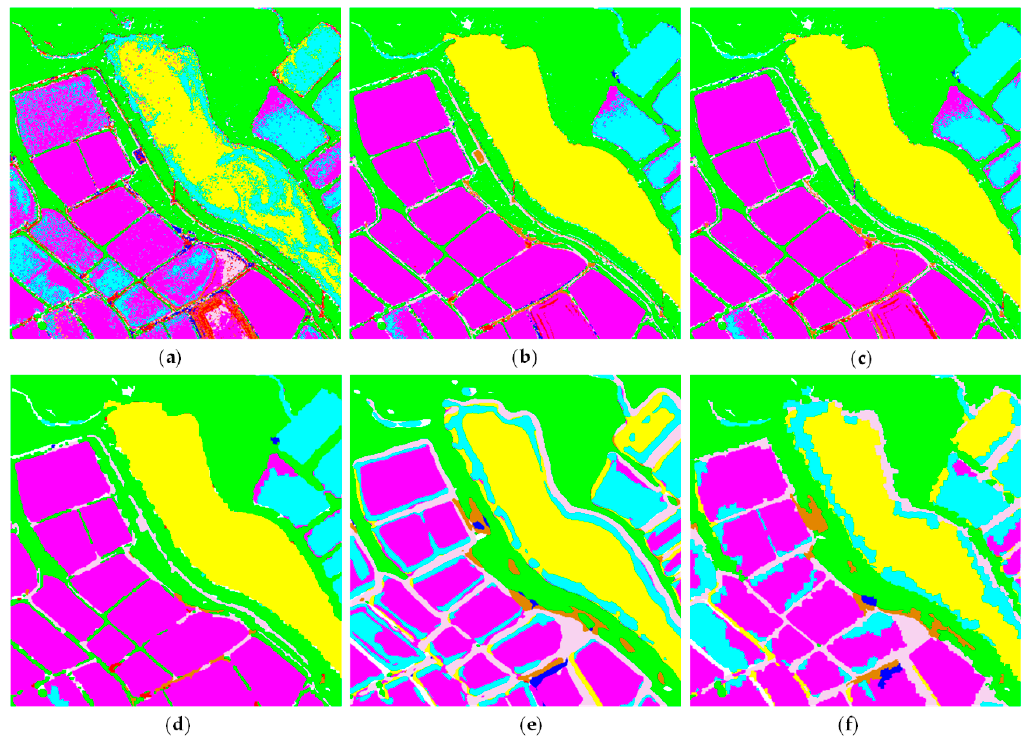
Figure 11. Local details of the classification results in aquafarm area. ( a ) Raw; ( b ) SS; ( c ) OSS; ( d ) OSS-MSSC; ( e ) VGG; ( f ) VGG-MSS.